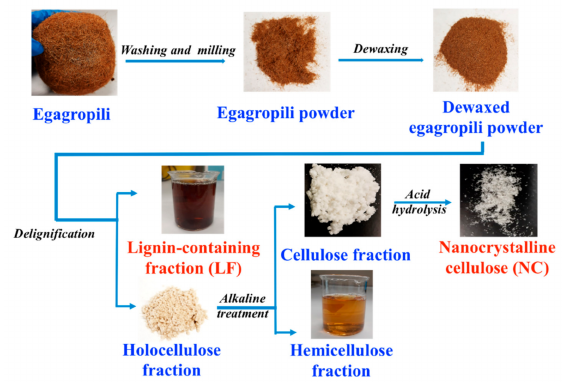
Figure 2. Scheme of the extraction procedure of nanocrystalline cellulose and lignin containing fraction from